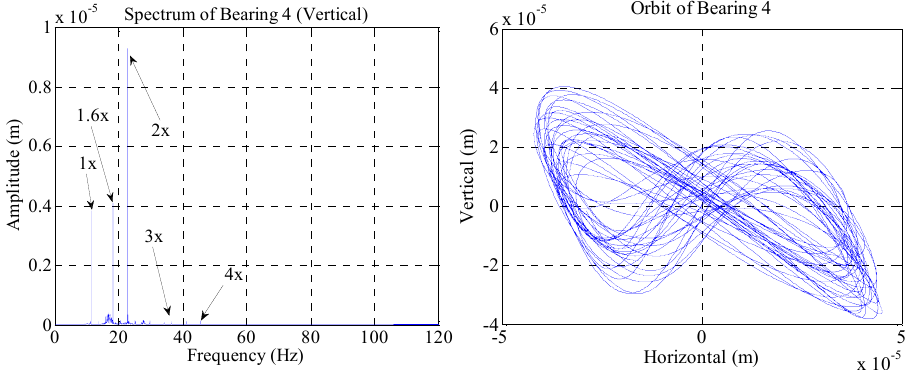
Figure 21. The spectrum and the orbit of Bearing